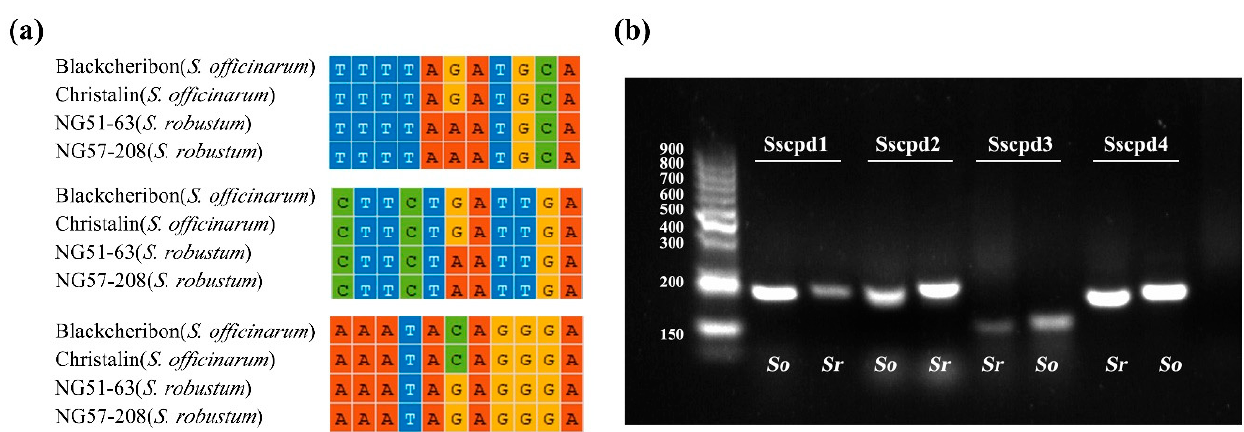
Figure 7. dCAPS makers design based on SNPs between S. robustrum and S. officinarum . ( a ) The multiple alignments of the chloroplast genomes by MAFFT, ( b ) SNP analysis with dCAPS primers, Sscpd1 and Sscpd2, designed for the SNP site in trnG-trnM region, with TaqI and XbaI restriction sites, respectively. Sscpd3 and Sscpd4 were designed for SNPs in petA-psbJ and rbcL-psaI intergenic region, with TaqI restriction sites. Abbreviated species names are shown on schematic diagrams, Ss , S. spontaneum , Sr , S. robustum , So , S. officinarum . The species-specific SNPs between S. sinense , S. barberi , and other Saccharum spp . (including S. hybrid , S. officinarum , S. robustum , and S. spontaneum ) were used to develop the dCAPS marker (Table 4). Sscpd5 designed for SNPs in the rbcL-psaI (“A” for S. sinense and